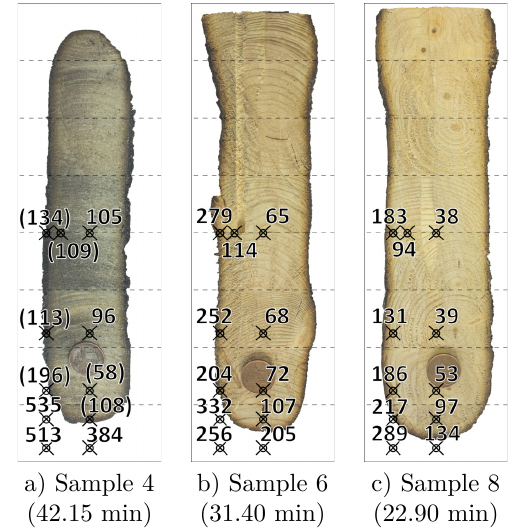
Figure 4. Temperature distribution [ ◦ C] within cross-section at the end of the fire test (the last mea- sured value before fluctuations occurred is presented in pictures in parentheses).